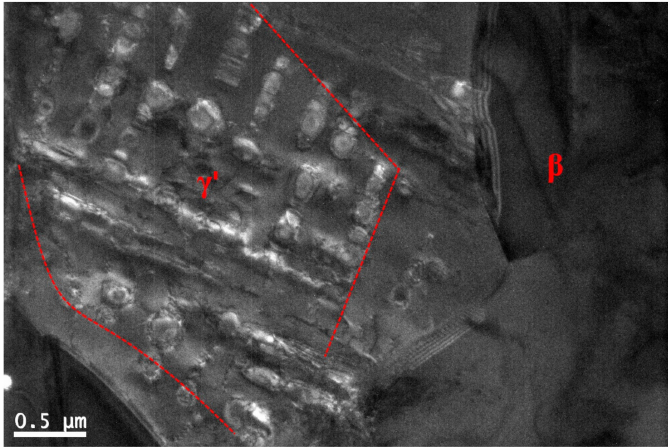
Figure 7. TEM micrographs of the γ ’ phase for Inconel 783 alloy bolts after 20,000 h aging at 700 ◦ C. The red line shows the depleted area of γ ’ phase around the β